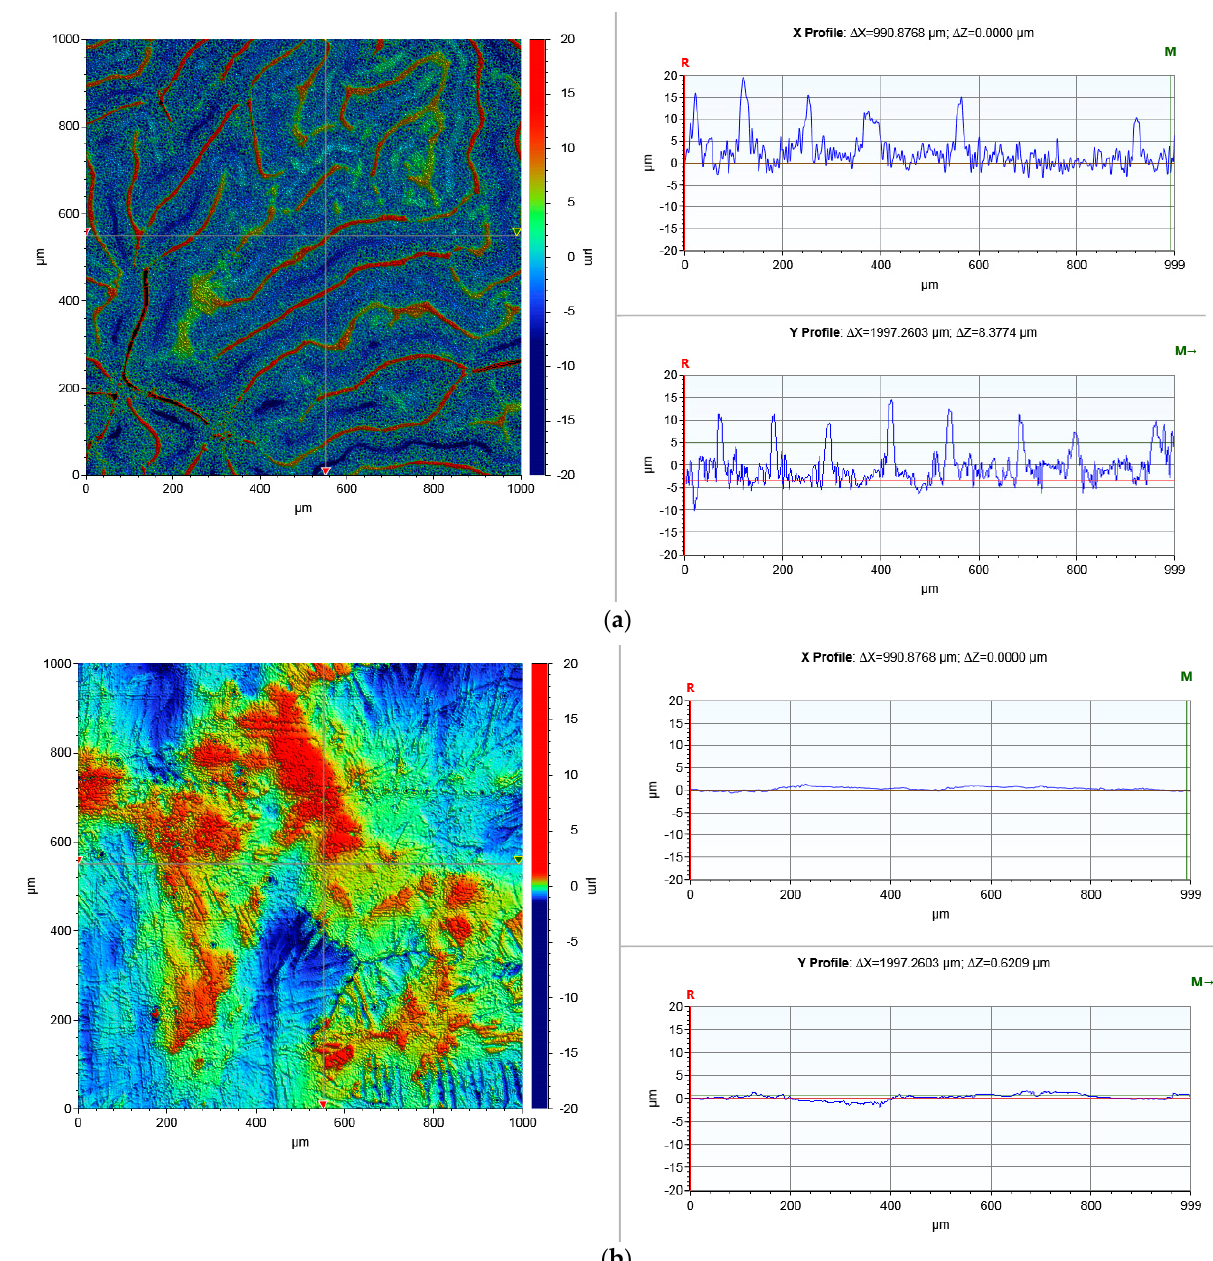
Figure 2. Selected profilogram of the coating surfaces of the “black” ( a ) and “white” ( b ) coatings. Coatings surface topography and selected profilograms from the X and Y directions of the coordinate system axis (marked with lines on the colored topographic chart). Table 2. Findings for the coating surface roughness profile tests.